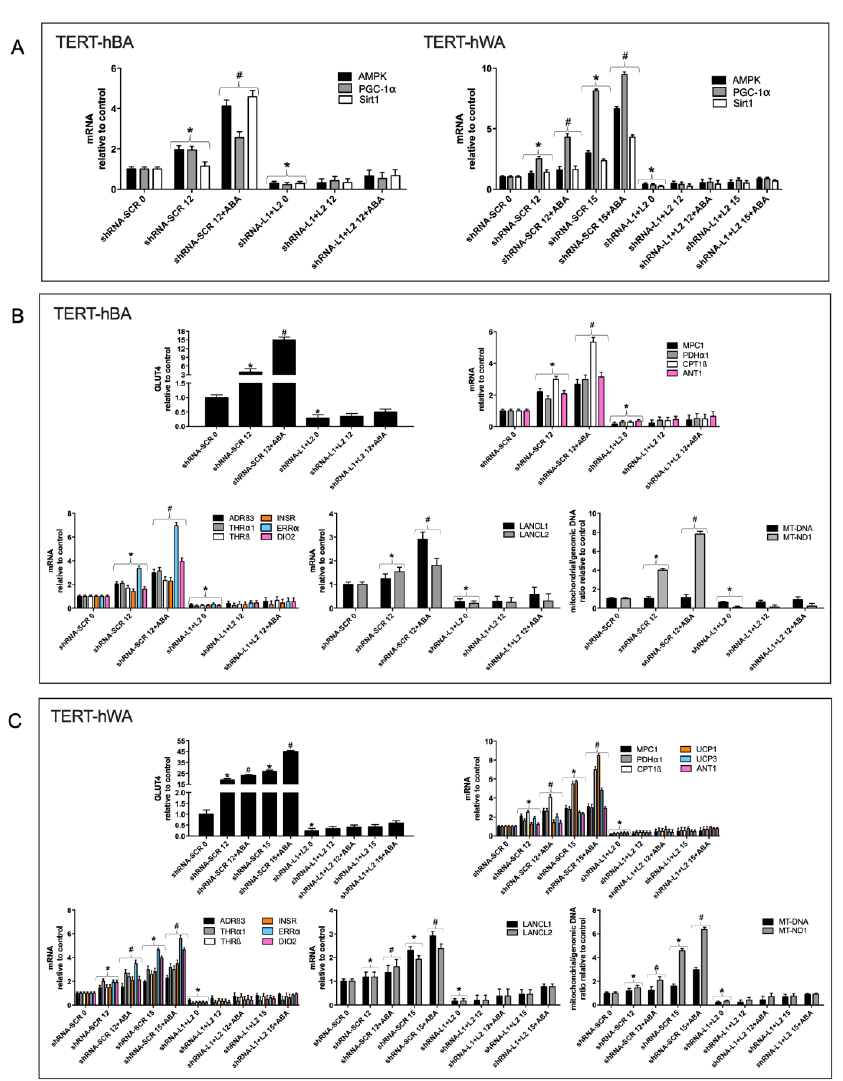
Figure 5. Transcriptional effects of the combined silencing of LANCL1/2 on differentiated brown and white adipocytes. Human brown (TERT-hBA) or white (TERT-hWA) preadipocytes silenced for the expression of LANCL1 and LANCL2 (shRNA-L1+L2), or control cells infected with the vec- tor containing scrambled sequences (shRNA-SCR), were differentiated to white or brown adipo- cytes in the absence or in the presence of 100 nM ABA: at days 0, 12 and 15 of culture, mRNA levels of the indicated genes were evaluated by qPCR. ( A ) analysis of the AMPK/PGC-1 α /Sirt1 signaling axis in TERT-hBA (left panel) and TERT-hWA (right panel). ( B ) TERT-hBA; upper left panel, GLUT4 mRNA; upper right panel, CPT1 β , MPC1, PDH α 1 and ANT1 mRNAs; lower left panel, ADR β 3, THR α 1, THR β , INSR, ERR α and DIO2 mRNAs; lower central panel, LANCL1/2 mRNAs; lower right panel, mitochondrial/genomic DNA ratio (MT-DNA and MT-ND1). * p < 0.02 relative to un- differentiated untreated control, # p < 0.006 relative to differentiated control. ( C ) TERT-hWA; upper left panel, GLUT4 mRNA; upper right panel, CPT1 β , MPC1, PDH α 1, UCP1, UCP3 and ANT1 mRNAs; lower left panel, ADR β 3, THR α 1, THR β , INSR, ERR α and DIO2 mRNAs; lower central panel, LANCL1/2 mRNAs; lower right panel, mitochondrial/genomic DNA ratio (MT-DNA and